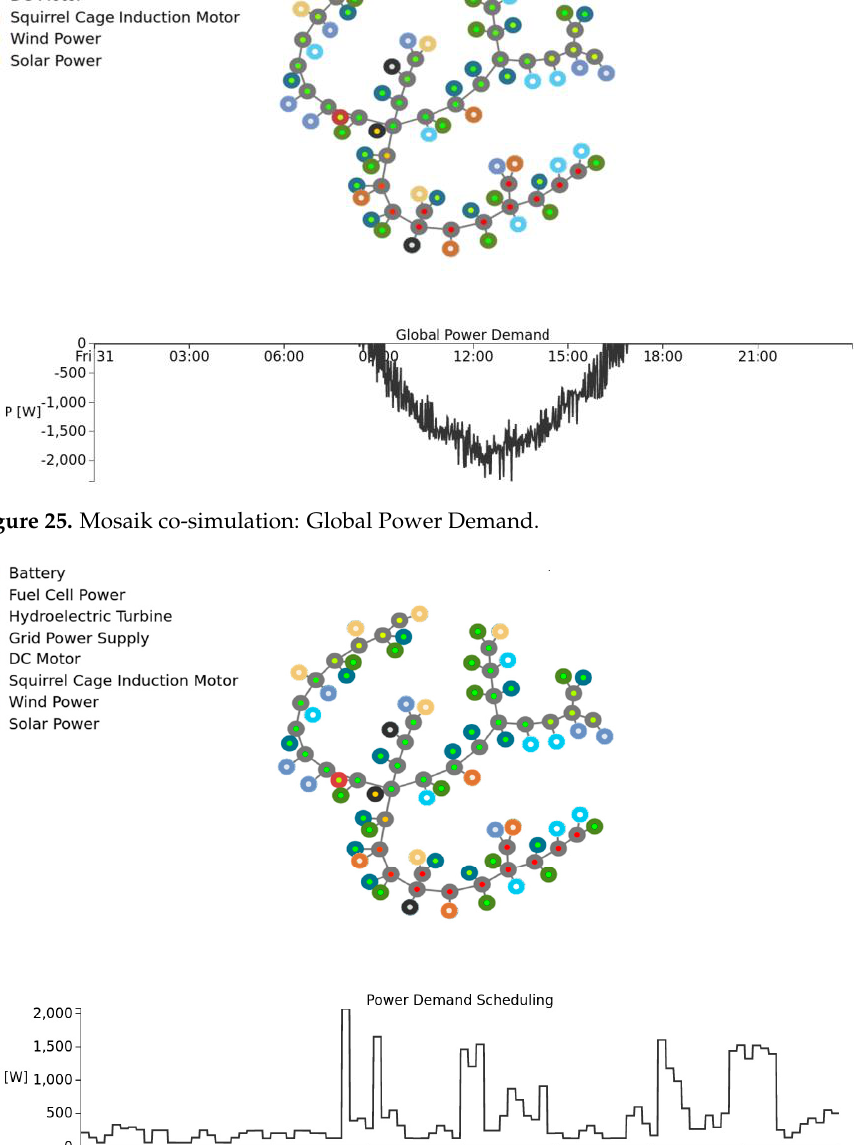
Figure 26. Mosaik co-simulation: Power Demand Scheduling.